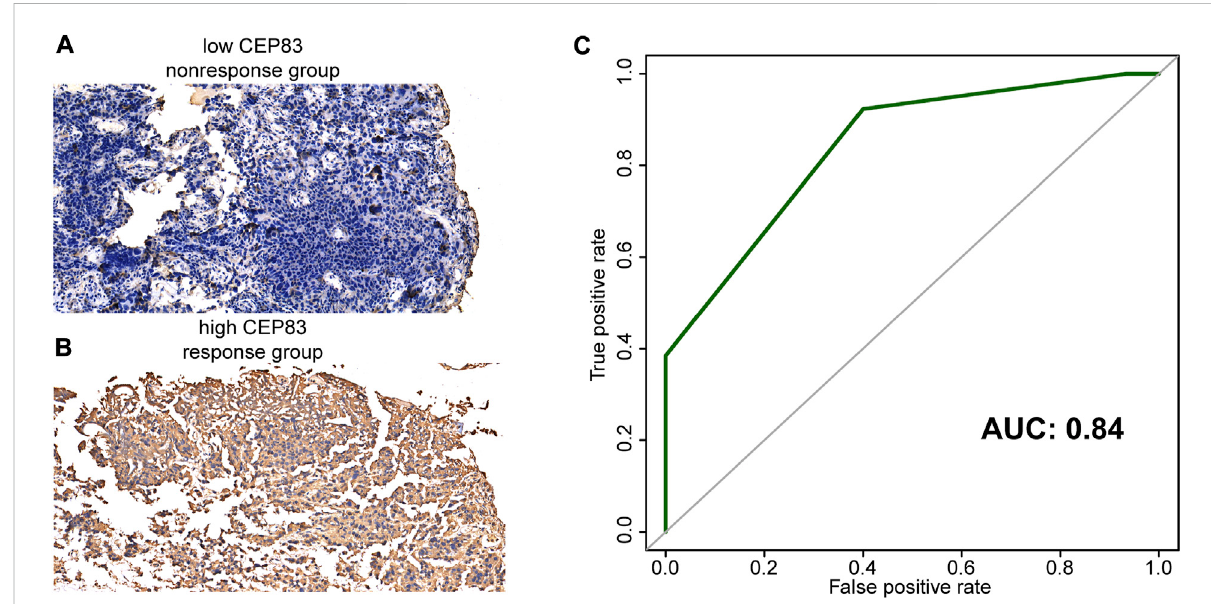
FIGURE 4 Representative images of CEP83 staining. (A) Negative staining (no response group). (B) Positive staining (response group). (C) Receiver operating characteristic curves (ROCs) of CEP83 in our IHC